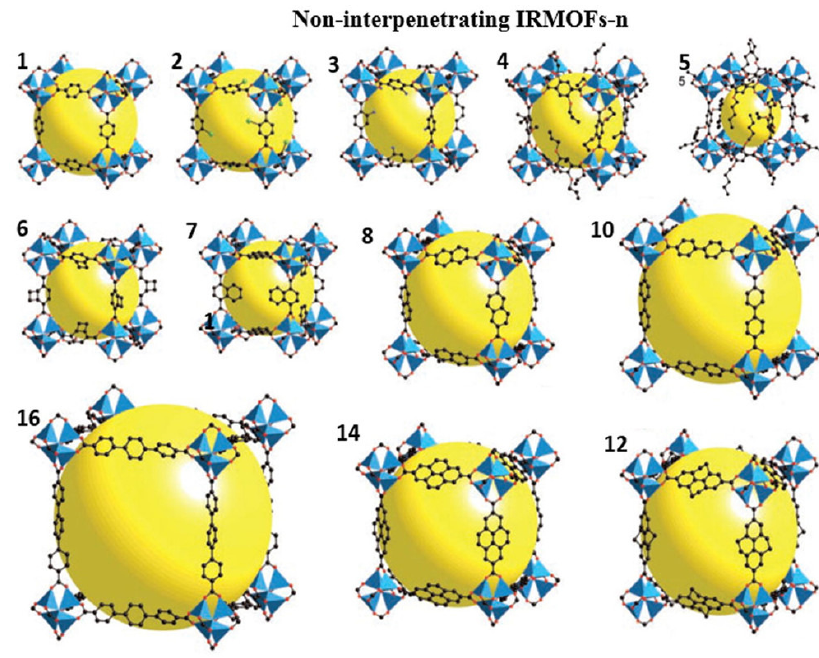
Figure 4. Structures of non-interpenetrating IRMOF-n ( n = 1–8, 10, 12, 14, and 16) [52].